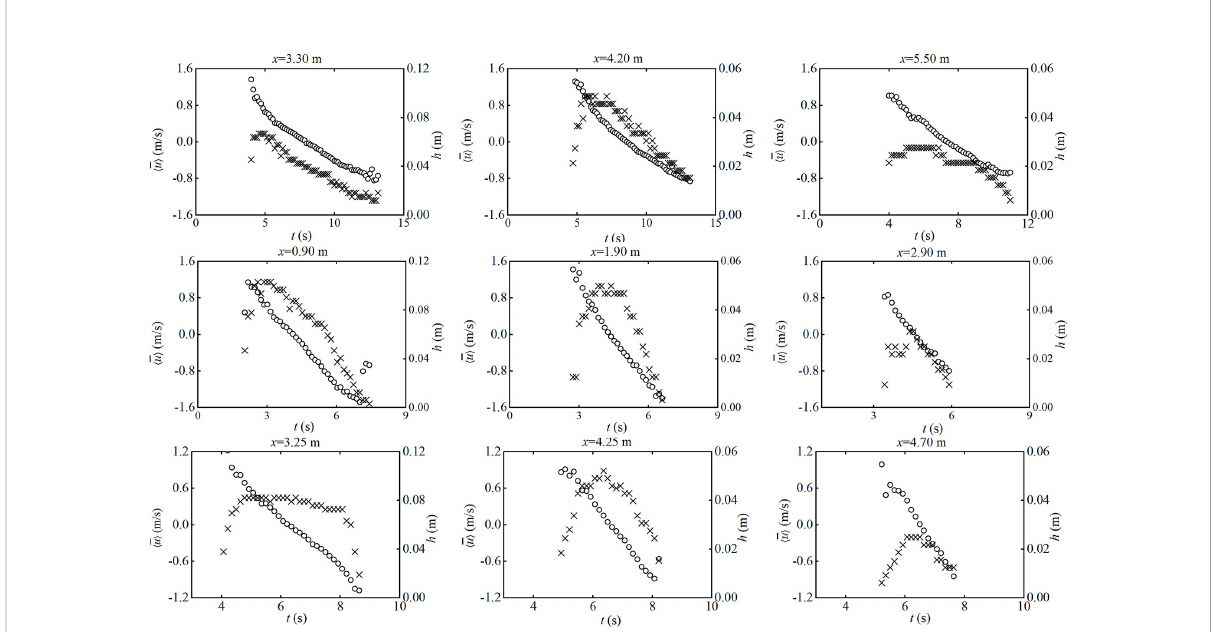
FIGURE 8 Time series of depth-averaged streamwise velocity (circle) and water depth (cross) for selected cross-shore locations. Upper row: mild beach; middle row: steep beach; lower row: composite